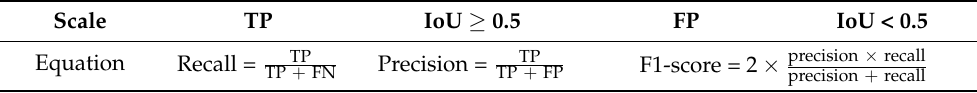
Table 1. Performance metrics for evaluation of the developed CNN models.